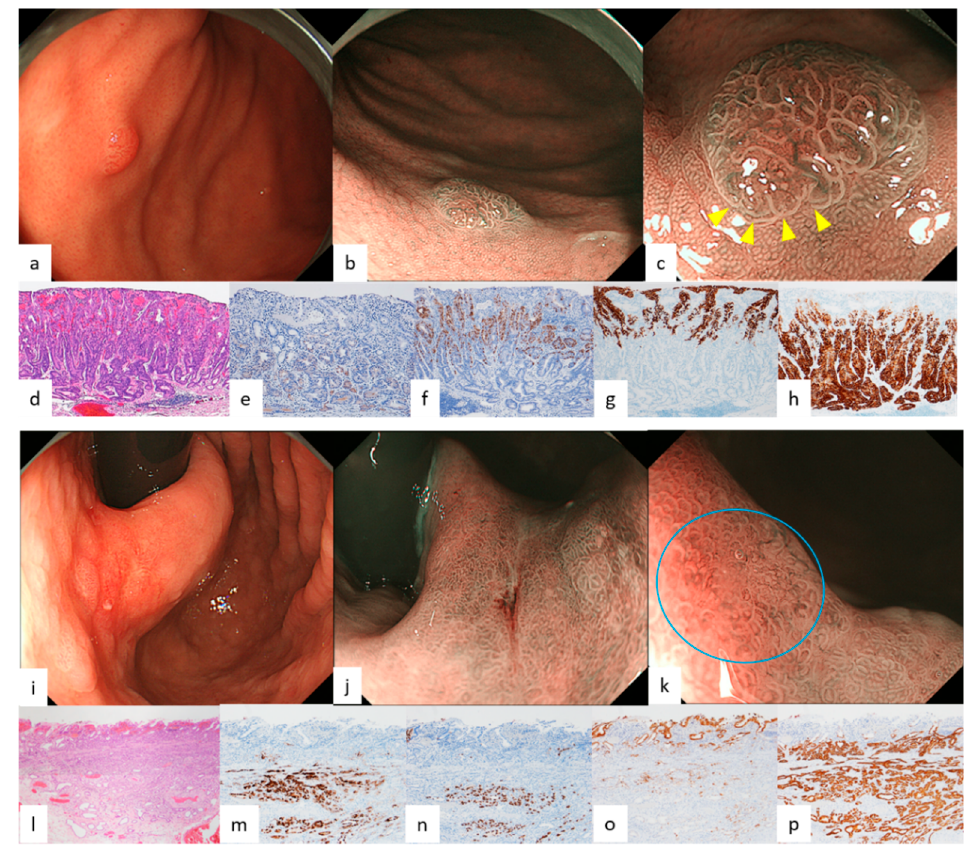
Figure 4. Endoscopic and pathological findings of GA-FGM (reddish elevated type, reddish flat or depressed type). ( a ) WLI. A reddish elevated lesion, 5 mm in size, was found in the posterior surface of the gastric fornix. No atrophic changes were observed in the background mucosa, and borders were distinct. Dilated vessels with branching architecture were found in the surface layer; ( b , c ) (M-)NBI. The pit-like structure of the perilesional fundic gland changed into a groove-like structure, making it possible to observe a distinct DL (yellow arrowhead). Irregular microvessels were found in the dilated IP. An irregular MV pattern plus regular MS pattern with a DL were observed by the MESDA-G; the lesion was diagnosed as cancerous; ( d ) HE stain (overall). Differentiated adenocar- cinoma differentiating into a foveolar epithelium-like structure was exposed on the surface, and tumor cells similar to chief cells proliferated primarily in the deep layer of the mucosa. ( e – h ): Im- munostain; ( e ) pepsinogen-I (chief cell). Positive in the middle and deep layers; ( f ) H+/K+-ATPase (parietal cell). Positive in the middle layer; ( g ) MUC5AC (gastric foveolar epithelial cell). Positive in the surface layer; ( h ) MUC6 (gastric mucous neck cell). Positive in the middle and deep layers; Final pathological diagnosis: U, 4 mm, gastric adenocarcinoma of fundic gland mucosa type, T1b/SM1 (300 μ m), UL0, Ly0, V0, pHM0, pVM0. ( i ) WLI. A reddish depressed lesion, 20 mm in size, with an indistinct border was seen on the posterior wall of the lesser curvature of the cardiac region. Atrophic changes were present in the background mucosa, as well as dilated vessels with branching architecture on the surface of the lesion; ( j ) M-NBI. There was no distinct DL, but dilatation of CO